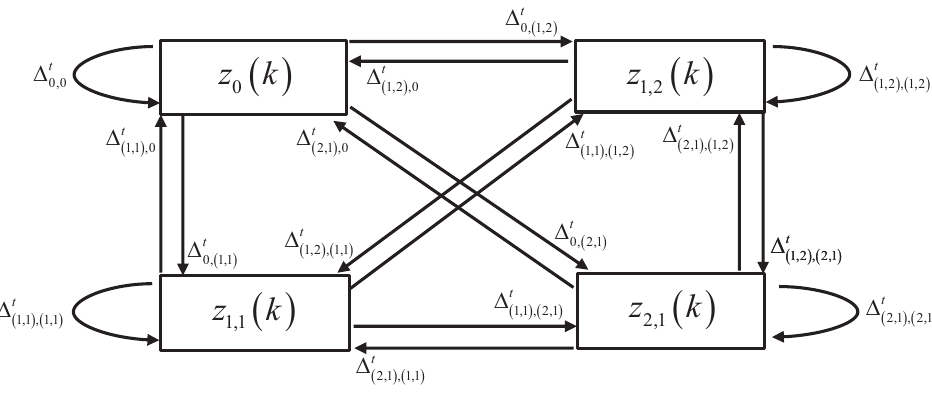
Figure 1. Transition relationship among the measurement cells of a